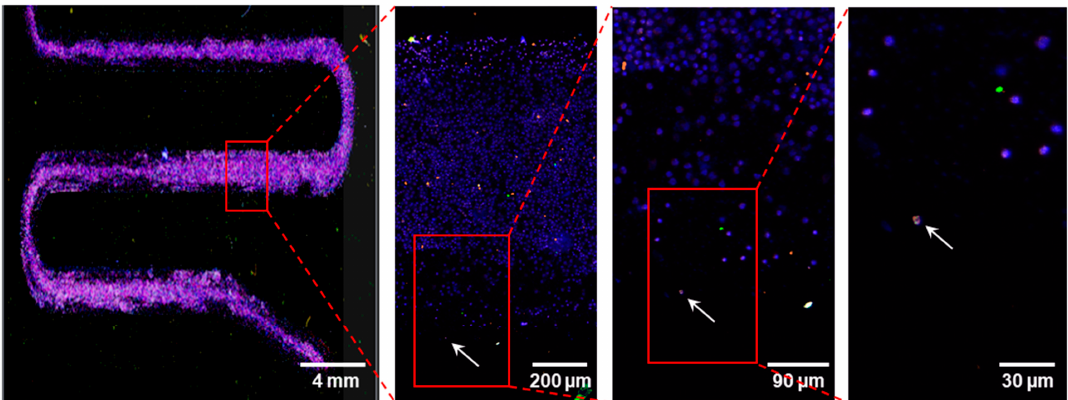
Figure 4. Images of fetal nucleated red blood cells (fnRBCs) enrichment on chambers of a Coral Chip.